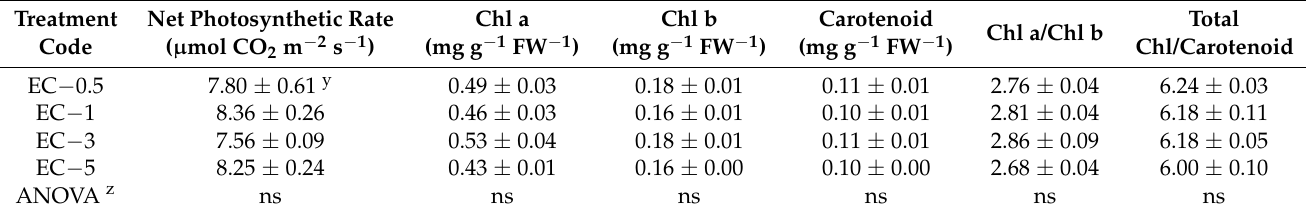
Table 2. The net photosynthetic rate, chlorophyll a (Chl a), chlorophyll b (Chl b), carotenoid contents, the values of Chl a/Chl b, and total Chl/carotenoid of basil leaves under 4 different EC treatments at 34 days after sowing in experiment